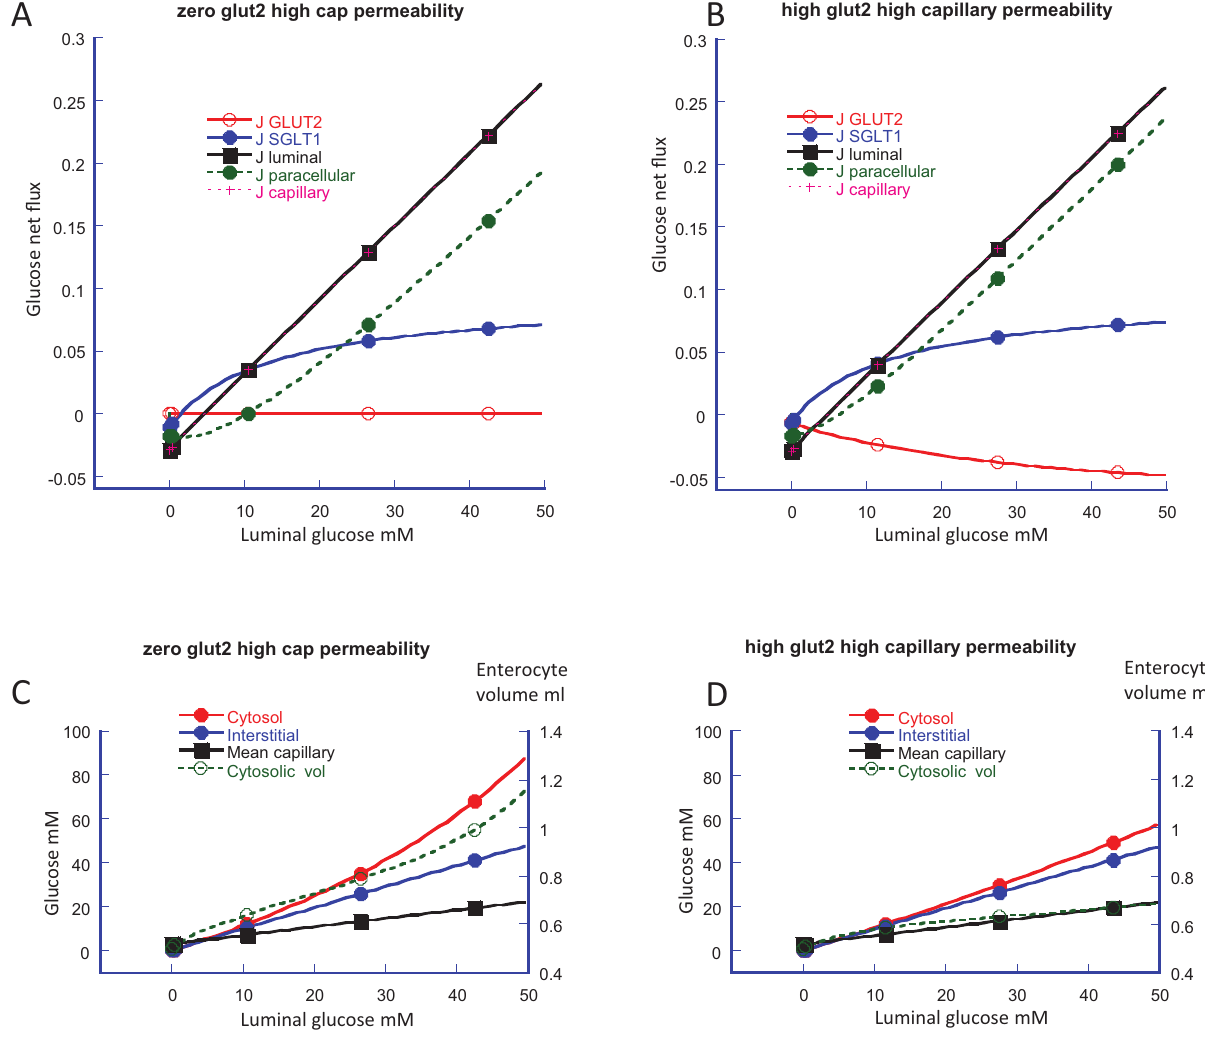
Figure 2. Simulation of altered apical membrane GLUT2 activity on intestinal glucose fluxes from zero (Panel A) to an arbitrary of maximal flux value of 2 (Panel B). The simulations show the glucose fluxes via apical SGLT1 (blue); apical GLUT2 (red); paracellular pathway (green); the total transluminal membrane, (SGLT1 + GLUT2 + paracellular fluxes), (black) and interstitial to capillary flow (pink crosses) inset on the black square. The main effect of increasing GLUT2 is to cause a negative glucose flux (backflux) via GLUT2 (Panel B ). This is accompanied by a increased paracellular flux without any significant change in net transluminal or transepithelial glucose flux. The point at which paracellular glucose flux and SGLT1 flux are equal lies between 20 and 30 mM as has been previously observed 4–6 . This value is used as one of the key registration points for the model. The cytosolic (red) interstitial (blue) and mean capillary glucose concentrations (black) and enterocyte volume per unit weight of tissue (green) are shown in panel C with zero apical GLUT2 and in Panel D with GLUT2 V = 2. max Increased apical GLUT2 activity decreases cytosolic glucose concentration (panel D ). With rising luminal glucose concentration raised GLUT2 activity prevents the non-linear increase in enterocyte volume seen with zero GLUT2 (Panel C